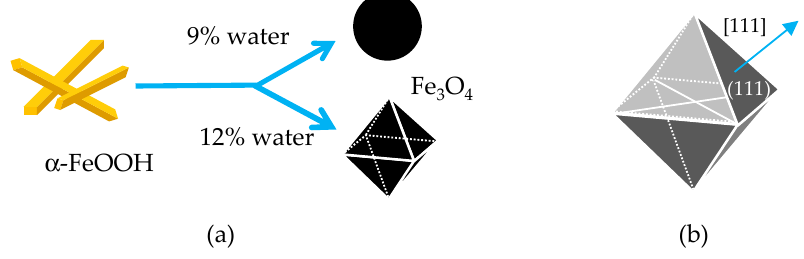
Figure 8. ( a ) Schematic of Fe 3 O 4 with disparate shapes resulting from different water concentrations in the EG–water mixed solvent used in the synthesis; ( b ) Fe 3 O 4 octahedron of a single crystal enclosed by eight {111} planes. <111>: easy axis of magnetization.